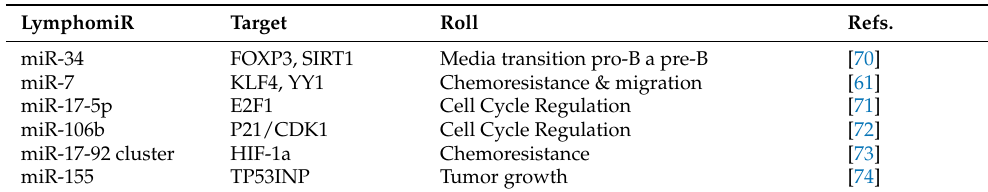
Table 4. lymphomiRs reported to be involved in lymphomagenesis.